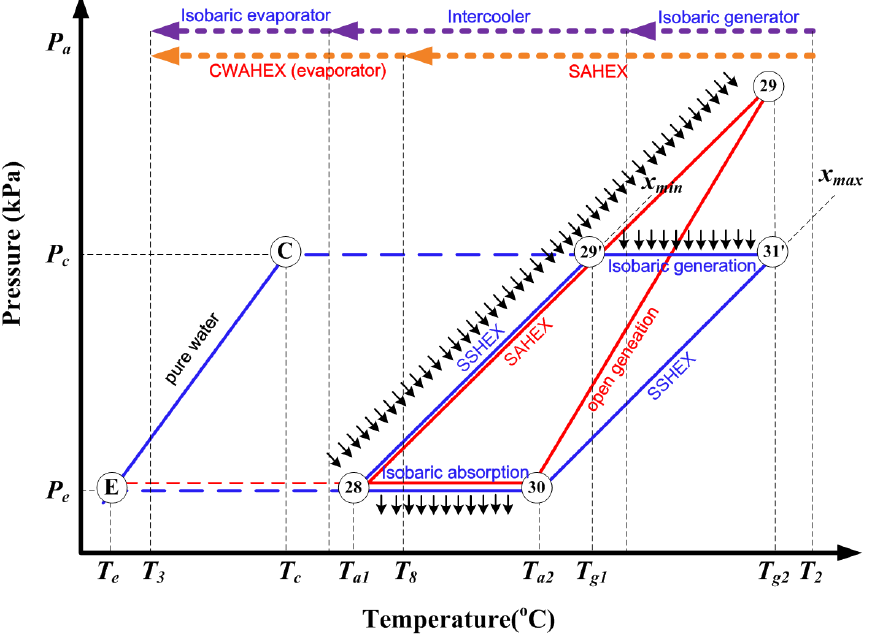
Figure 3. Schematic of a cryogenic air separation unit coupled with an open-cycle absorption